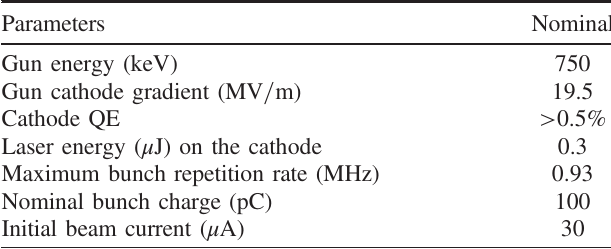
TABLE I. LCLS-II electron source